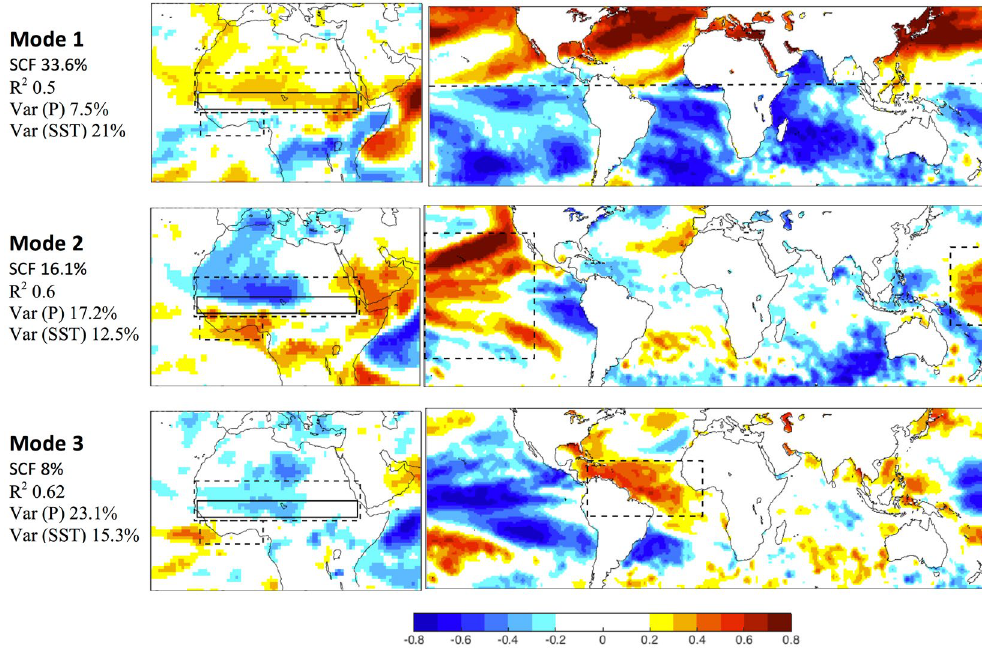
Figure 4. Leading mode derived from the MCA analysis of June to September (JJAS) precipitation (P) and sea surface temperature (SST) anomalies of AFFO-2d-S – CON-2d simulations from 1998 to 2012: P (left) and SST (right). In the P modes the dashed line represents the areas of the footprint (south Sahara) and the Gulf of Guinea coast; solid lines represent the afforested area (the Sahel). In the SST modes dashed lines represent the ocean basin area associated with the precipitation pattern over North Africa: Mode 1: Inter-hemispheric, Mode 2: Tropical pacific and Mode 3: Atlantic Ocean. The square covariance fraction (SCF) of each mode, the correlation (R 2 ) between the MCA of the P and SST in the modes and the fraction of the variance (Var) of the given P and SST modes are presented. Maps were created using Matlab R2014b